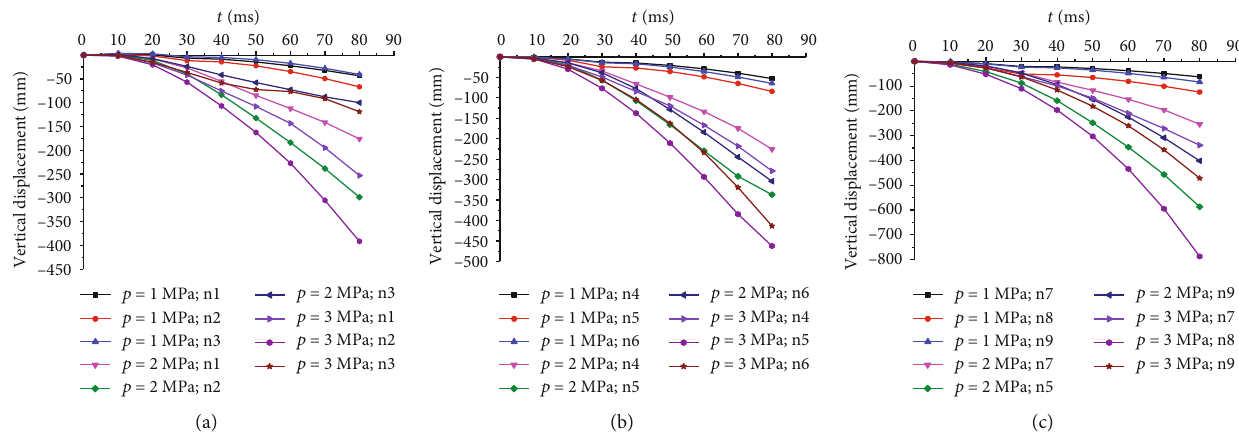
Figure 5: The trend of vertical displacement at the 9 measuring points in the conditions of p = 1 , 2, and 3MPa: (a) n1 ~ n3 on HL1; (b) n4 ~ n6 on HL2; (c) n7 ~ n9 on HL3 with p = 1 , 2 and